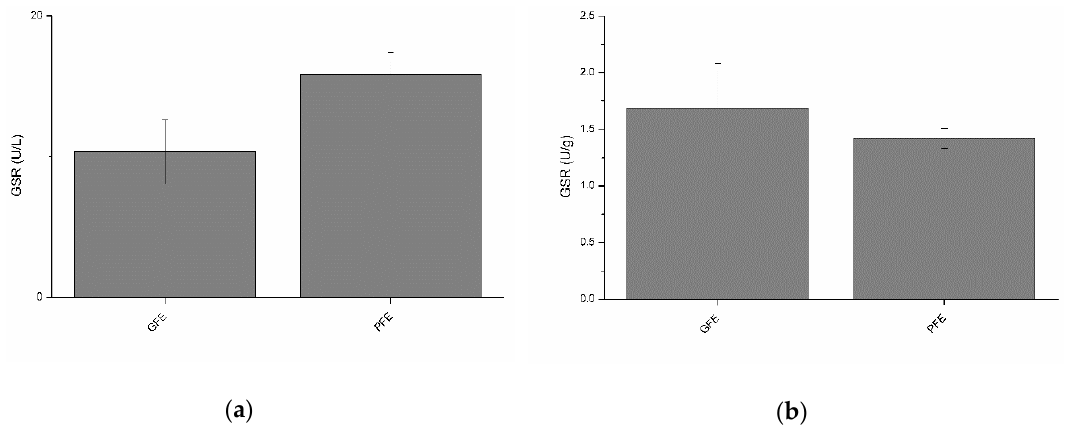
Figure 4. Glutathione reductase activities in stallion seminal plasma (mean ± SEM): ( a ) total activity; ( b ) specific activity. No significant ( p > 0.05) differences between good (GFE) and poor freezability ejaculates (PFE) were observed.